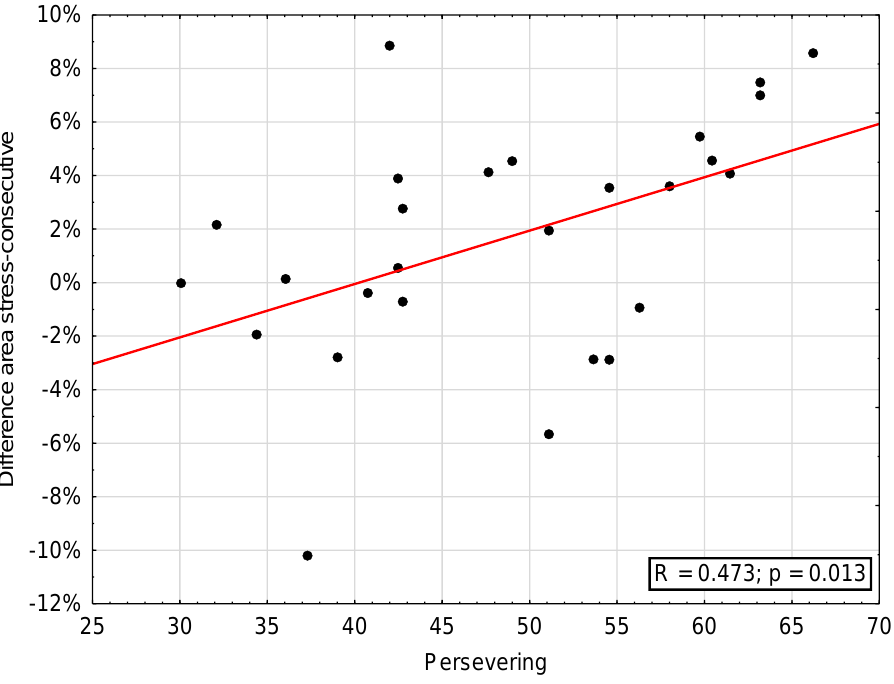
Figure 4. Correlation between difference of areas on “stress” and “consecutive” days and the subscale “persevering” of the coping questionnaire (SVF) .